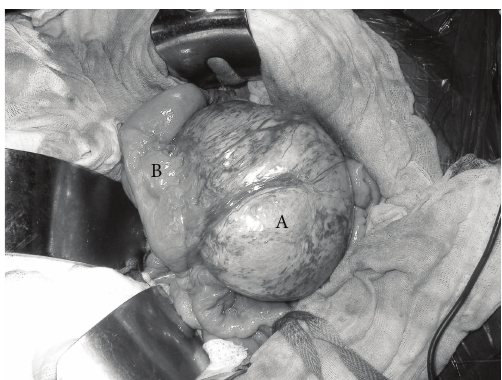
Figure 2: Intraoperative view: A: desmoid-type fibromatosis (15 × 10 × 6.5 cm); B: ileal loop and mesentery involved.